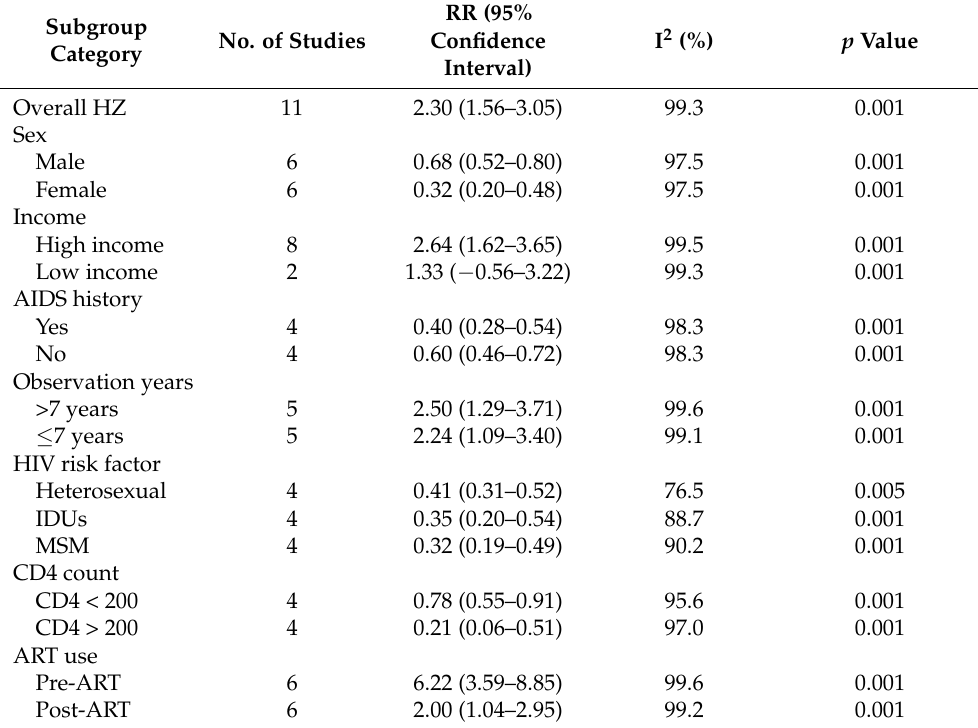
Table 2. Subgroup analysis of HZ incidence in different